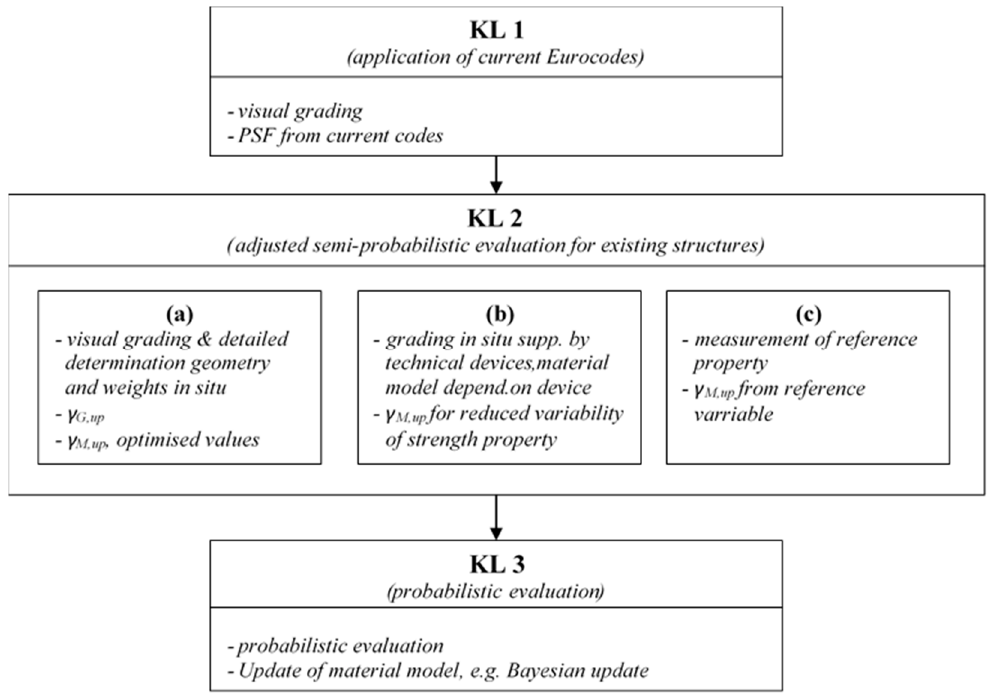
Figure 1. Framework for the evaluation of the load-bearing capacity of existing structures.